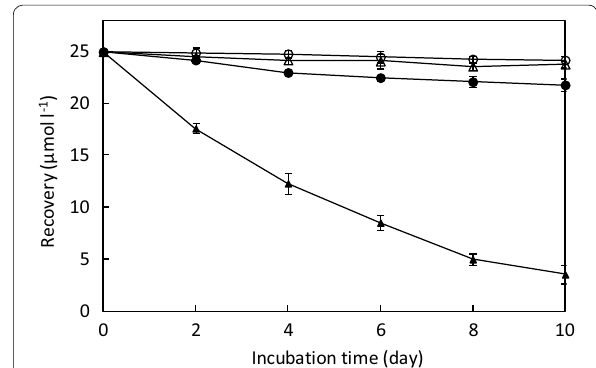
Fig. 2 Time courses for degradation of PCA ( closed circles ) and TCHQ ( closed triangles ) by P. acanthocystis in LN medium. Recovery of PCA ( open circles ) and TCHQ ( open triangles ) from control cultures was also shown. Values are mean SD of triplicate samples ±